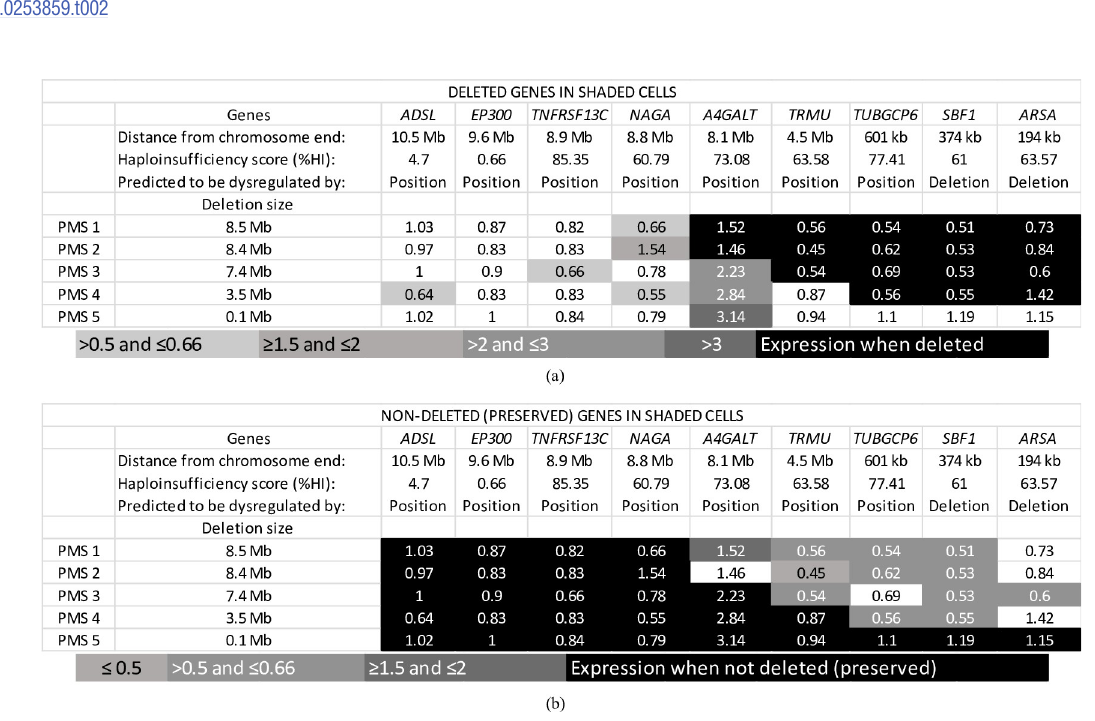
The ‘ ✓ ‘ represents presence of the gene in the individual, the ‘ ✘ ’ represents deletion of the gene in the individual. Shaded cells represent the genes within 2 Mb for the individual mentioned in the first row of that column. Hg19 UCSC genome browser [31].